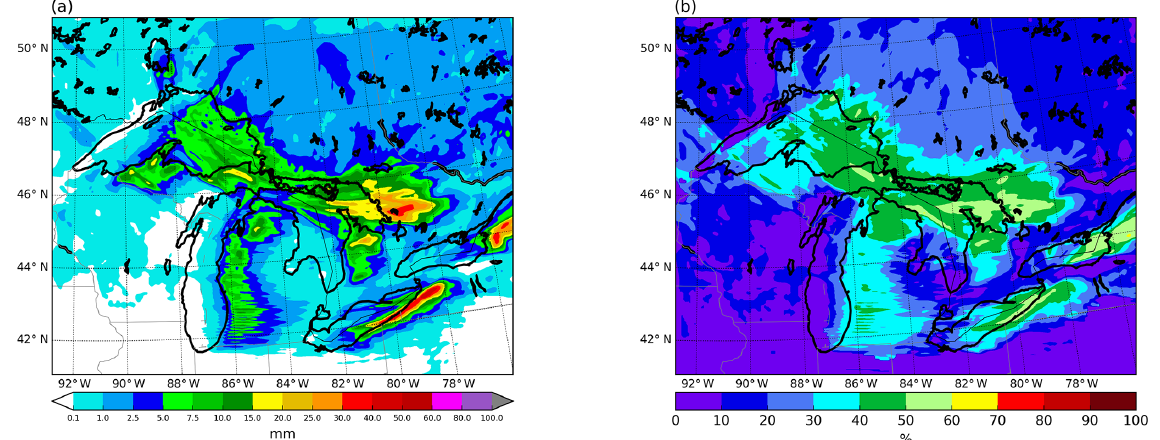
Figure 13. Simulated accumulated tracer snow water equivalent (i.e., coming from the lakes’ evaporation) (mm) (a) and its percentage contribution to total simulated accumulated snow water equivalent (b) from 17 November at 06:00UTC to 21 November at